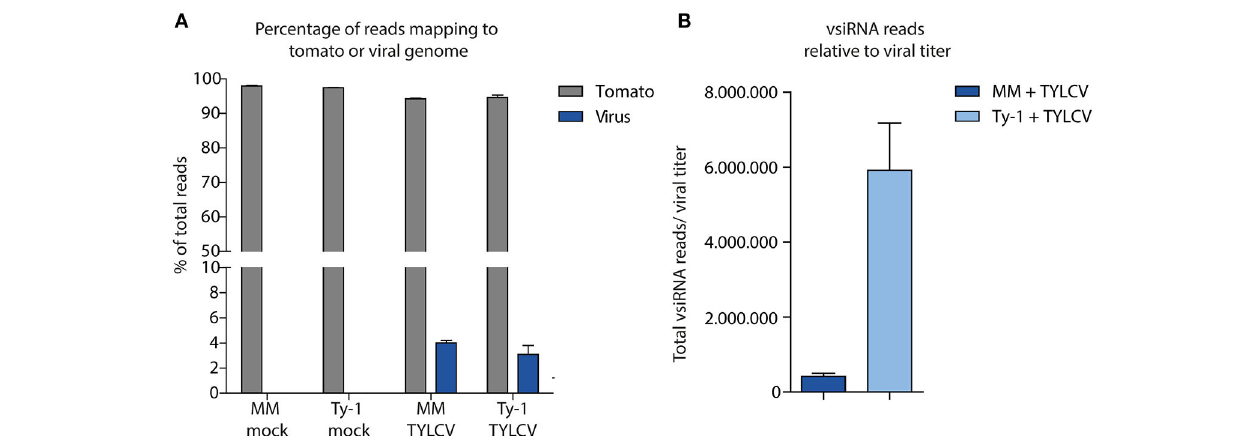
FIGURE 2 | Distribution of sRNAs mapping to the tomato genome or viral genome. (A) sRNAs were isolated from mock-treated and TYLCV-infected susceptible MM and Ty-1 bearing tomato and subsequently sequenced. The sRNAs were mapped to either the tomato genome or the viral genome using Bowtie2. The percentage of reads mapping to either the tomato or TYLCV genome relative to the total reads is depicted. Each bar represents the mean percentage and standard deviation of three biological replicates. (B) The number of sRNAs mapped to the viral genome was corrected for the relative amount of virus found in the samples according to qPCR. The bars represent the mean and standard deviation of three biological replicates.